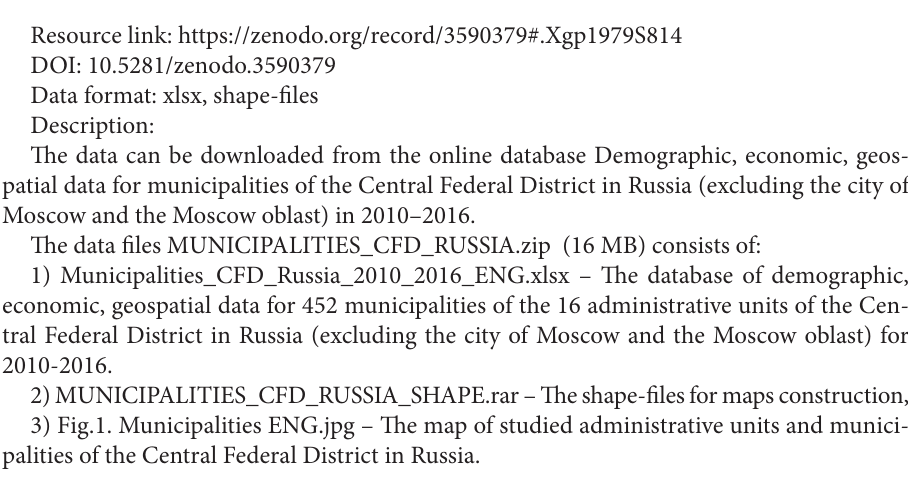
Figure 1. Map of studied administrative units and municipalities. Source : constructed by the